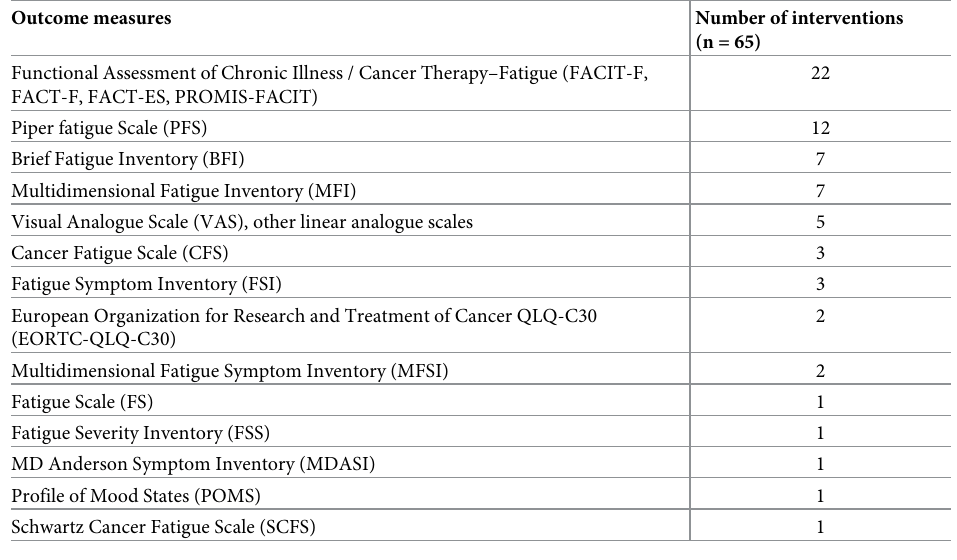
Table 3. We also investigated whether researchers facilitated patients in the gradual acquisition of self-managed activities into a daily routine, mapping the conduct of any supervised sessions before the period of autonomy–most of them included gradually introducing “homework assignments” and independent exercising–and the strategies adopted to help maintain long- term treatment adherence, as illustrated in Table 4. With respect to the outcomes, many scales have been used across studies for CRF assess- ment, along with a set of secondary outcomes, as illustrated in Table 5. The most used scales were the Functional Assessment of Chronic Illness / Cancer Therapy–Fatigue scale (FACIT, Table 5. Primary outcome measures for cancer-related fatigue